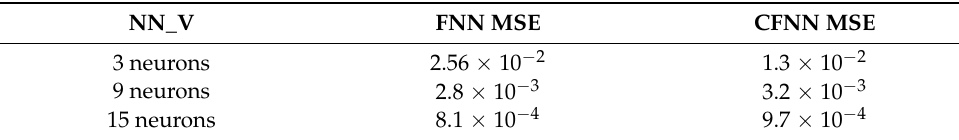
Figure 7. Normalized P–V characteristics of the PV panel showing operating point for T = 25 °C. Table 2. MSE for FFNN and CFNN for NN_V for V dc ’ regression.